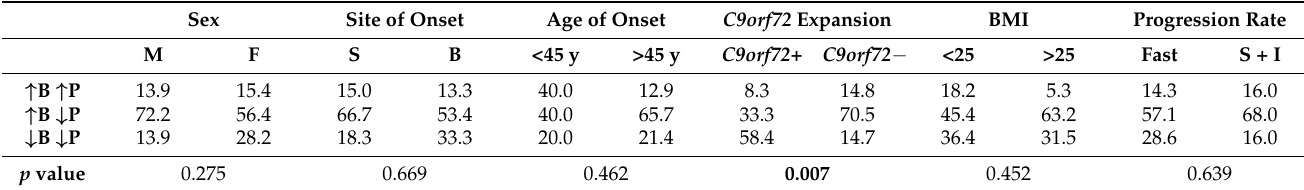
Table 5. Associations with ALS clinical variables stratifying ALS patients based on BDNF and Pro-BDNF trends versus